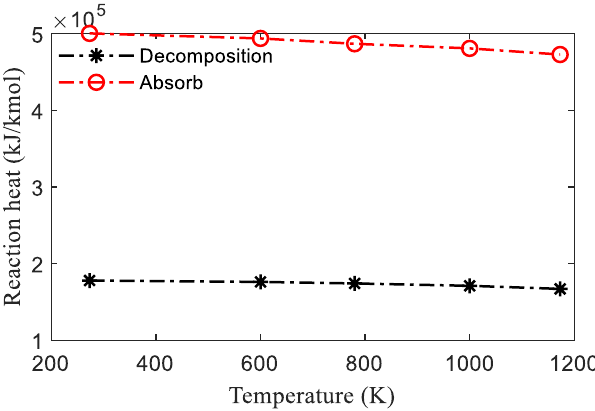
Figure 3. Chemical reaction heat of calcium injection desulfurization in the furnace.